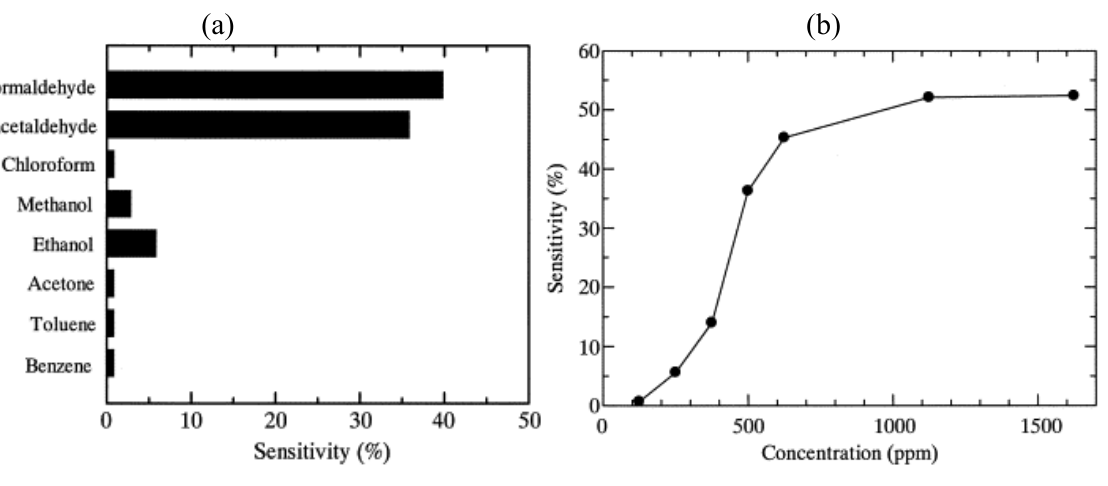
Figure 7. (a) Sensitivity of PPy/EBSA films at room temperature upon exposure to different analytes (500 ppm) and (b) the change of sensitivity as function of analyte concentration, reprinted from [85] with permission from